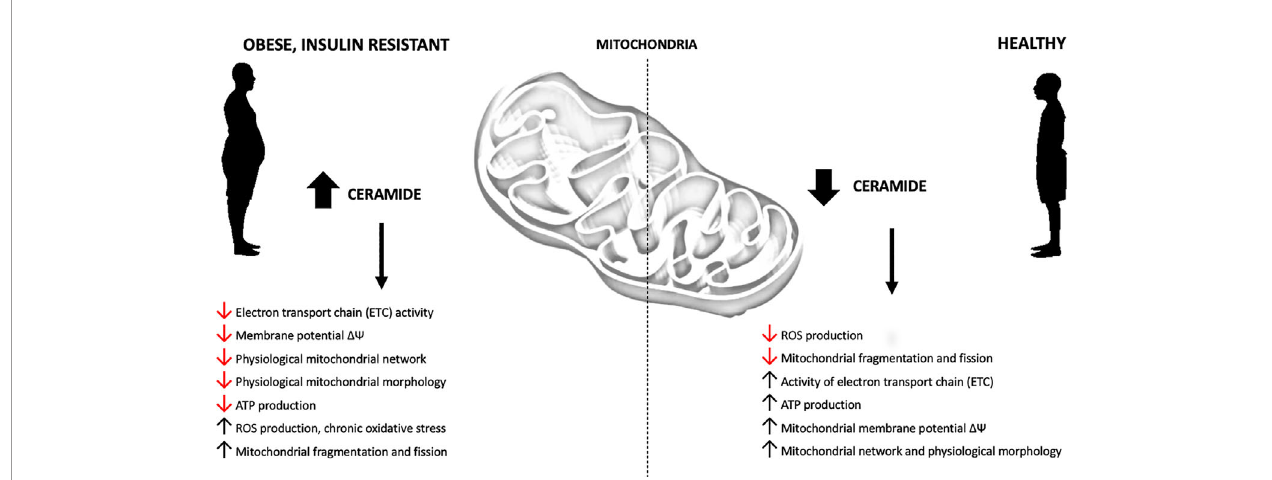
FIGURE 3 | Obesity-related effects of ceramide accumulation on mitochondrial